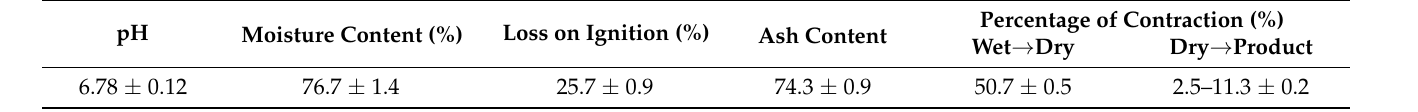
Table 1. The main physicochemical characteristics of residual